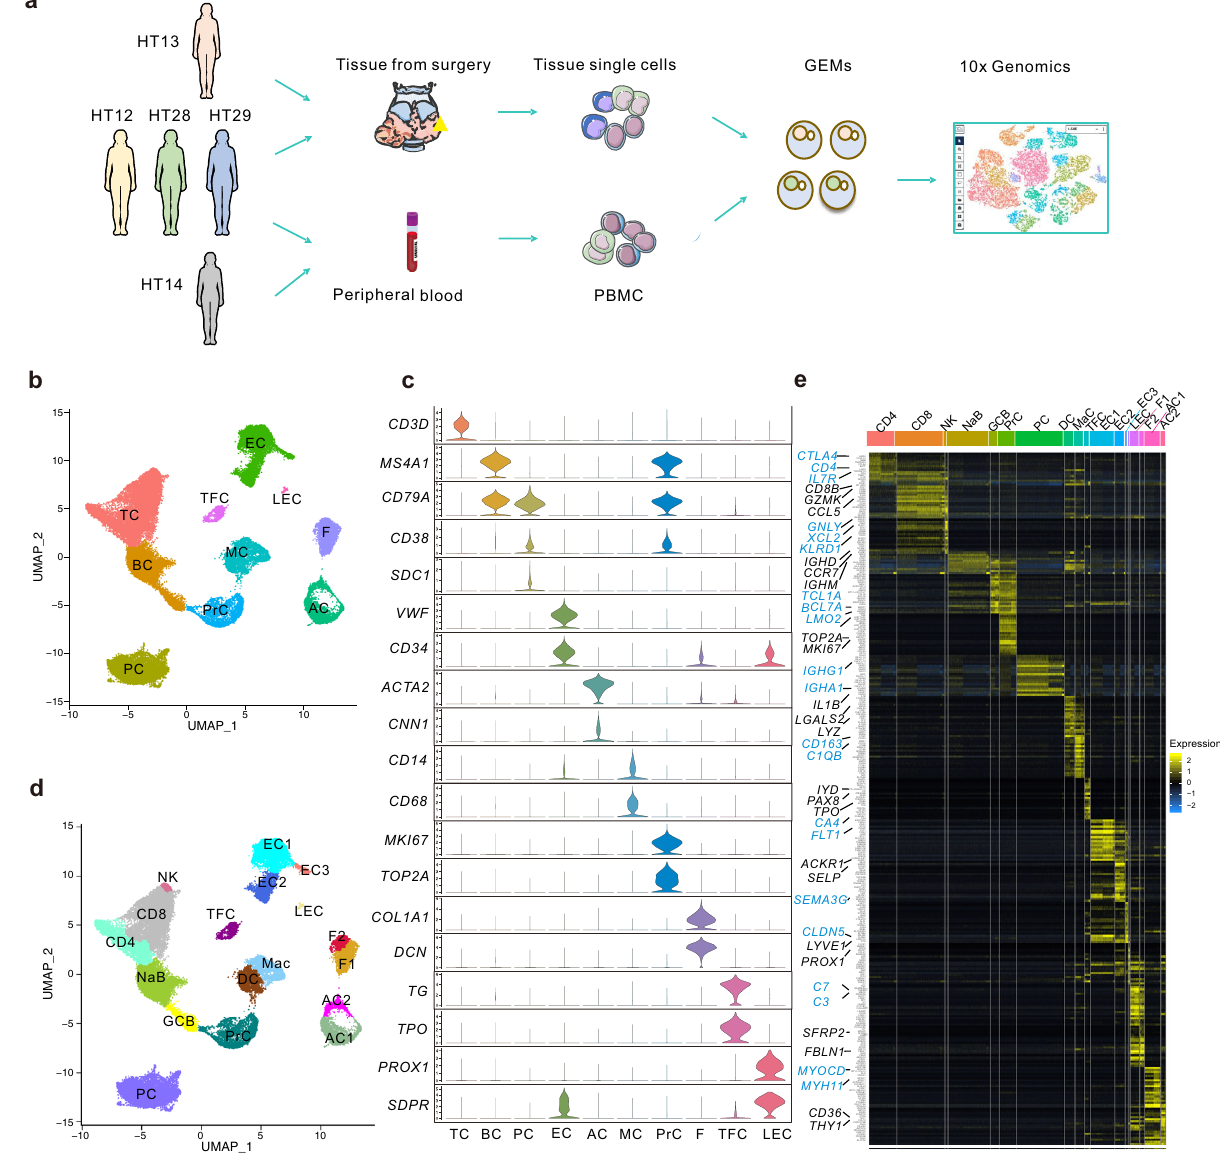
Fig. 1 Single-cell RNA sequencing and clustering of cells from the thyroid of HT patients. a Schematic showing sample work fl ow from operating room to sequencing. b UMAP of total cells from the thyroid tissues of HT patients after quality control, colored by cluster identity. c Violin plots showing the expression levels of representative marker genes across the clusters. The y axis shows the normalized read count. d UMAP of cells from the thyroid tissues of HT patients, colored by subgroup identity. e Single-cell expression heatmap displaying selected top marker genes of per cell cluster based on differential expression testing. TCs T cells, BCs B cells, PrCs proliferative cells, PCs plasma cells, MCs myeloid cells, TFCs thyroid follicular cells, ECs endothelial cells, LECs lymphocytic vessels endothelial cells, F fi broblasts, AC ACTA2 + cells, DC dendritic cells, Mac macrophages. NaB naive B cells, GCB germinal center B